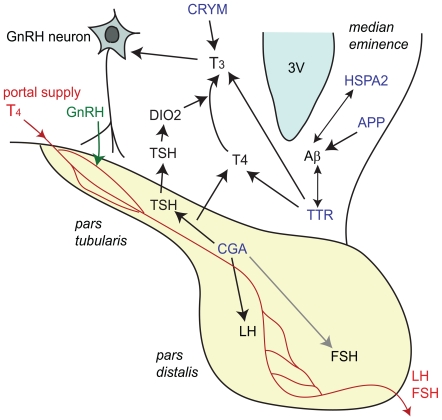
Schematic diagram showing the regulation of thyroid hormone action in pars tuberalis of pituitary and hypothalamus.Blue indicates genes that were significantly affected in the current microarray study: common glycoprotein alpha subunit (CGA), transthyretin (TTR), μ-crystallin (CRYM), and heat shock 70 KDa protein (HSPA2), and amyloid-β precursor protein (APP). TSH: thyroid stimulating hormone, DIO2: type-2 deiodinase, LH: luteinizing hormone, FSH: follicular-stimulating hormone, 3 V: third ventricle, T3: L-triiodothyronine, T4: thyroxine.